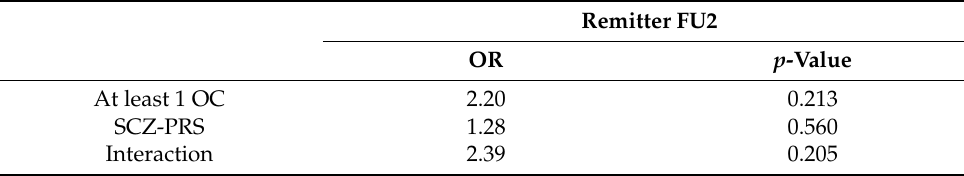
Table 4. Logistic regression results for GxE interaction ( n =